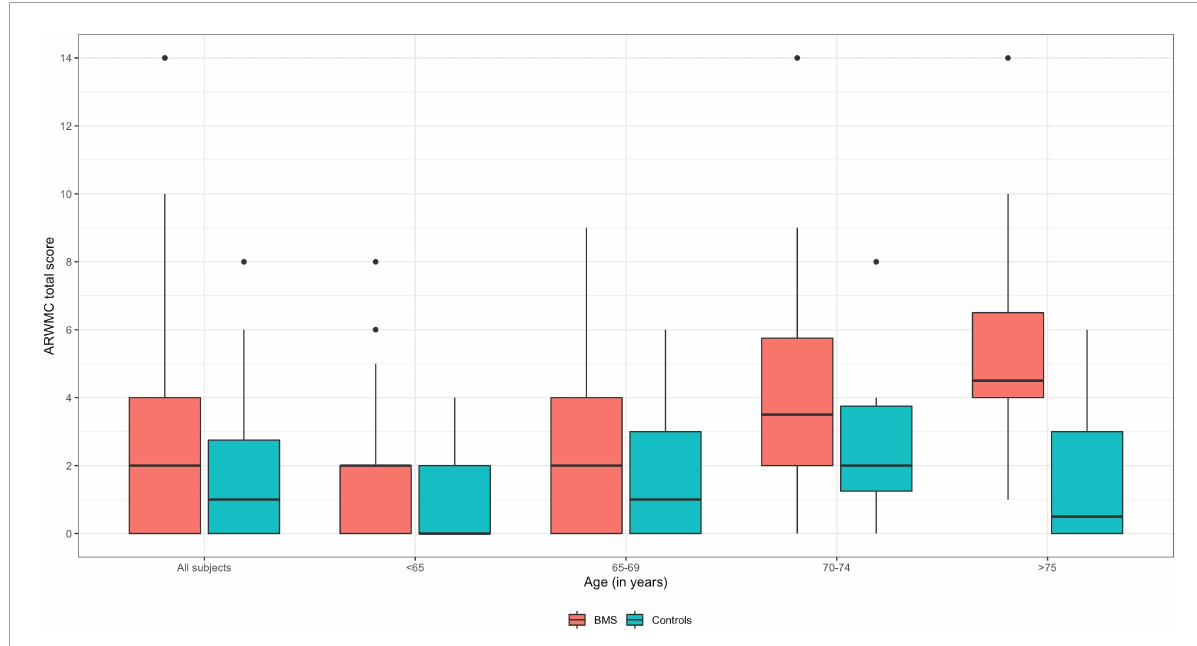
FIGURE4 Boxplot of ARWMC total score of BMS and control subjects according to the age subgroups. Median values are highlighted by bold